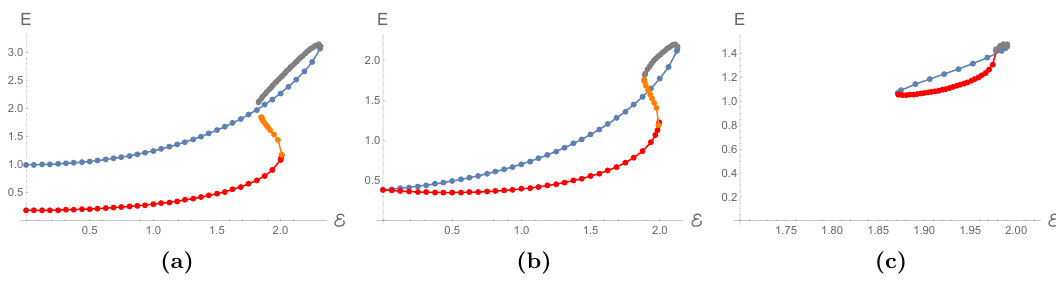
Figure 16. Total energy at the boundary for the dual state of the black hole for G T = 1 =(cid:25) , T = 0 : 275665 and T = 0 : 24179 from left to